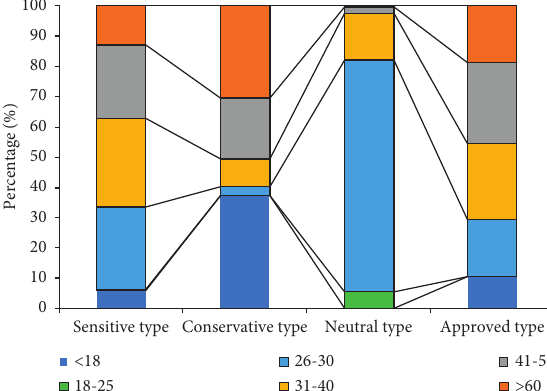
Figure 8: Age of drivers in the four segments.